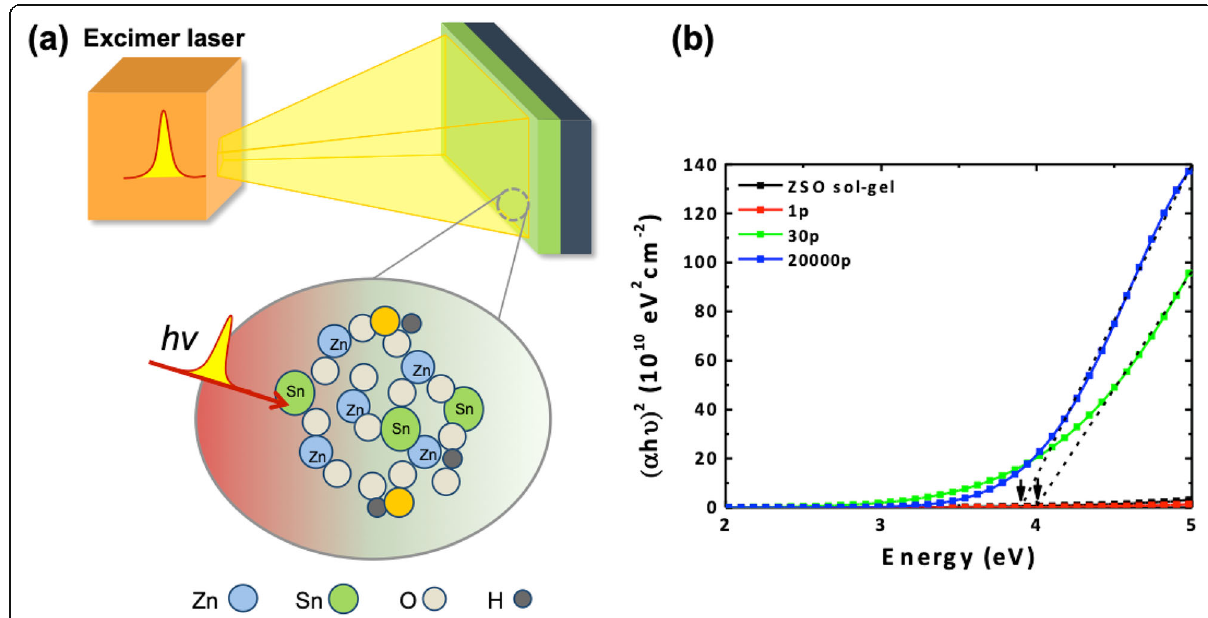
Fig. 1 a Schematic figure of excimer laser annealing of sol-gel thin films at room temperature. b Optical absorption spectra ( α ) of the ZTO (ZnSnO x ) films with variation of laser annealing duration. The red lines represent the linear extrapolation of ( α h ν ) 2 to the x -axis, for estimating the